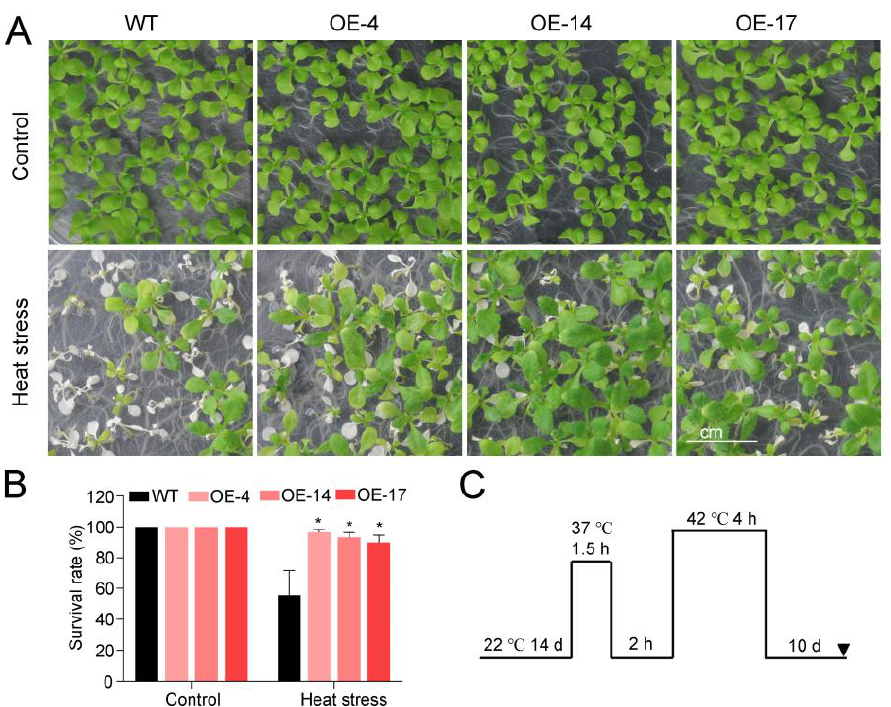
Figure 4. Heterologous expression of HuTZF3 enhanced tolerance to heat stress in Arabidopsis. ( A , B ) Two-week-old Arabidopsis WT and overexpressing HuTZF3 plants were exposed to heat treatment ( A ), and their survival rate ( B ) after recovering. The experiments were repeated three times with similar results. Values are means ± SD ( n = 40 plants). Asterisks show the values that are significant compared to WT. * p < 0.05 according to the Student’s t -test. The scale bar is 1 cm. ( C ) Schematic diagram of heat treatment